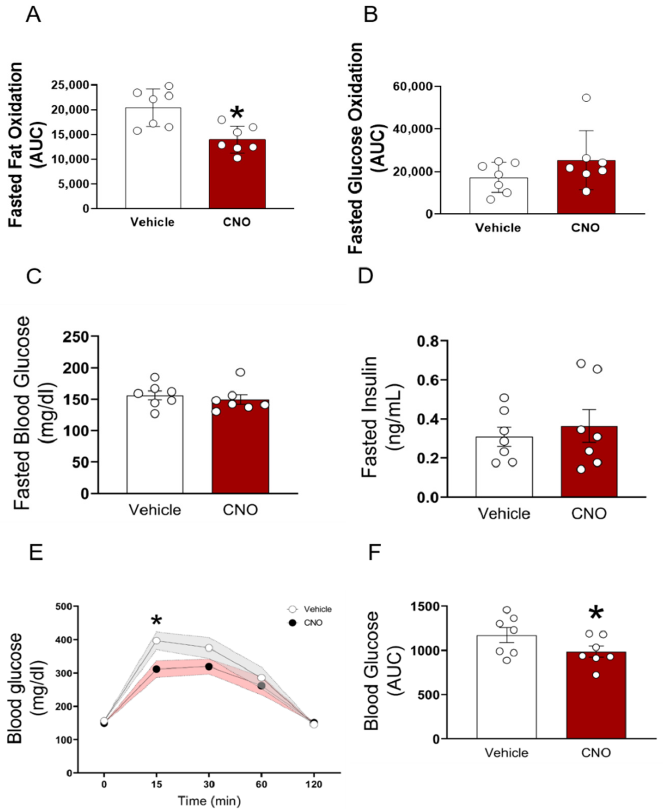
Figure 4. Acute activation of ARC GHR neurons decreases fat oxidation and increases glucose tolerance. ( A ) Fasted fat oxidation and ( B ) fasted glucose oxidation, measured in metabolic chambers. Mice were i.p. injected with either saline (grey) or CNO (red) 1 h prior the start of the fasting period during the dark cycle. ( C ) Fasted blood glucose, ( D ) fasted insulin, ( E ) glucose tolerance tests (GTT), and ( F ) AUC of 12-week old male mice. Saline (gray) or CNO (0.3 mg/kg BW i.p, red) was injected 1 h before i.p. GTT. The effect of ARC GHR activation was analyzed using a residual maximum likelihood (REML) mixed model followed by Sidak’s post hoc. The AUC was analyzed with a paired t-test. Mean ± SEM, n = 7; * p < 0.05. See also Figure S4B.